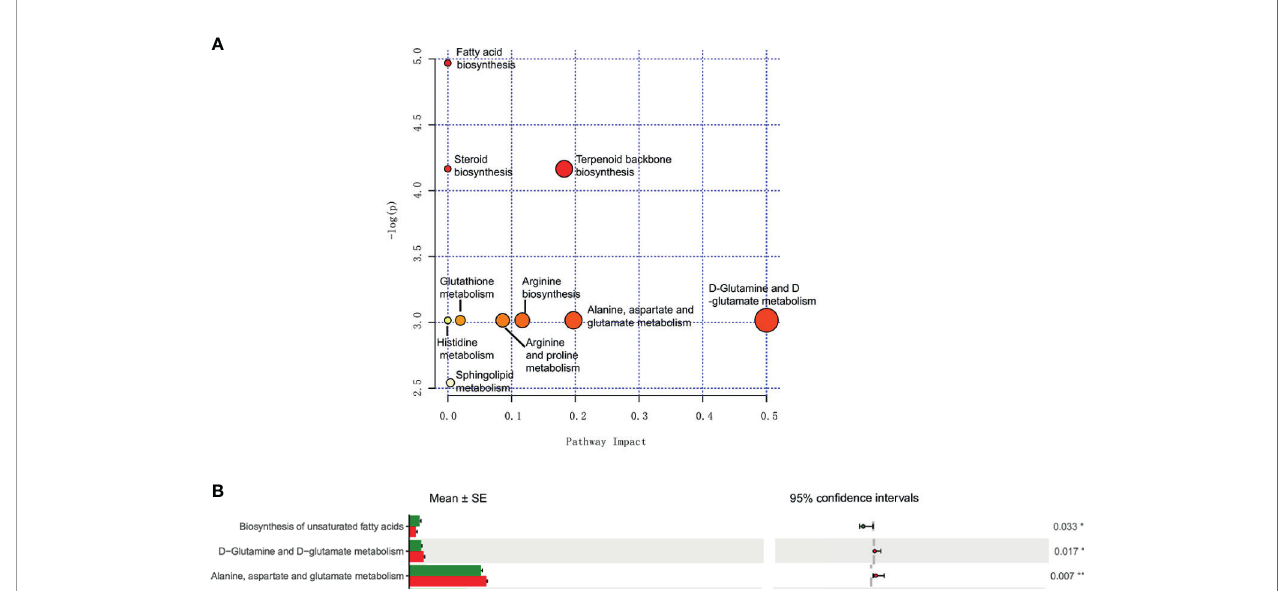
FIGURE 5 | Metabolomic and microbiomic comparison in IC. Pathway analysis of urinary metabolites in MetPA identi fi ed sphingosine metabolism, fatty acid biosynthesis, and amino acid metabolism as signi fi cantly altered in IC (p < 0.05) (A) . PICRUSt analyses identi fi ed biosynthesis of unsaturated fatty acids, and amino acid metabolism as signi fi cantly different (p < 0.05) (B) . *p < 0.05; **p <